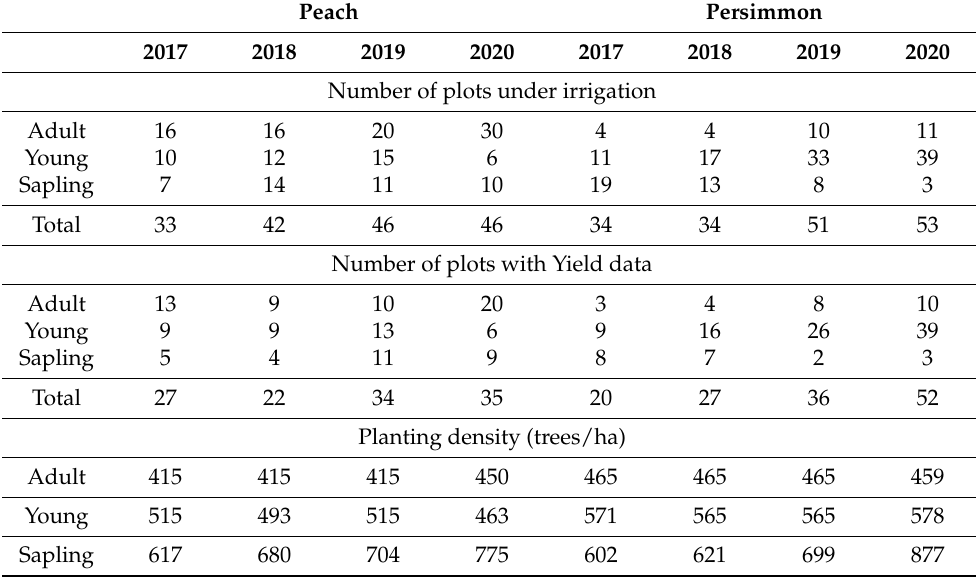
Table 3. Number of plots under irrigation, number of plots with yield data, and planting densities for each crop and tree size, from 2017 to 2020 of the plots considered in the indicators analysis. Peach Persimmon Number of plots under irrigation